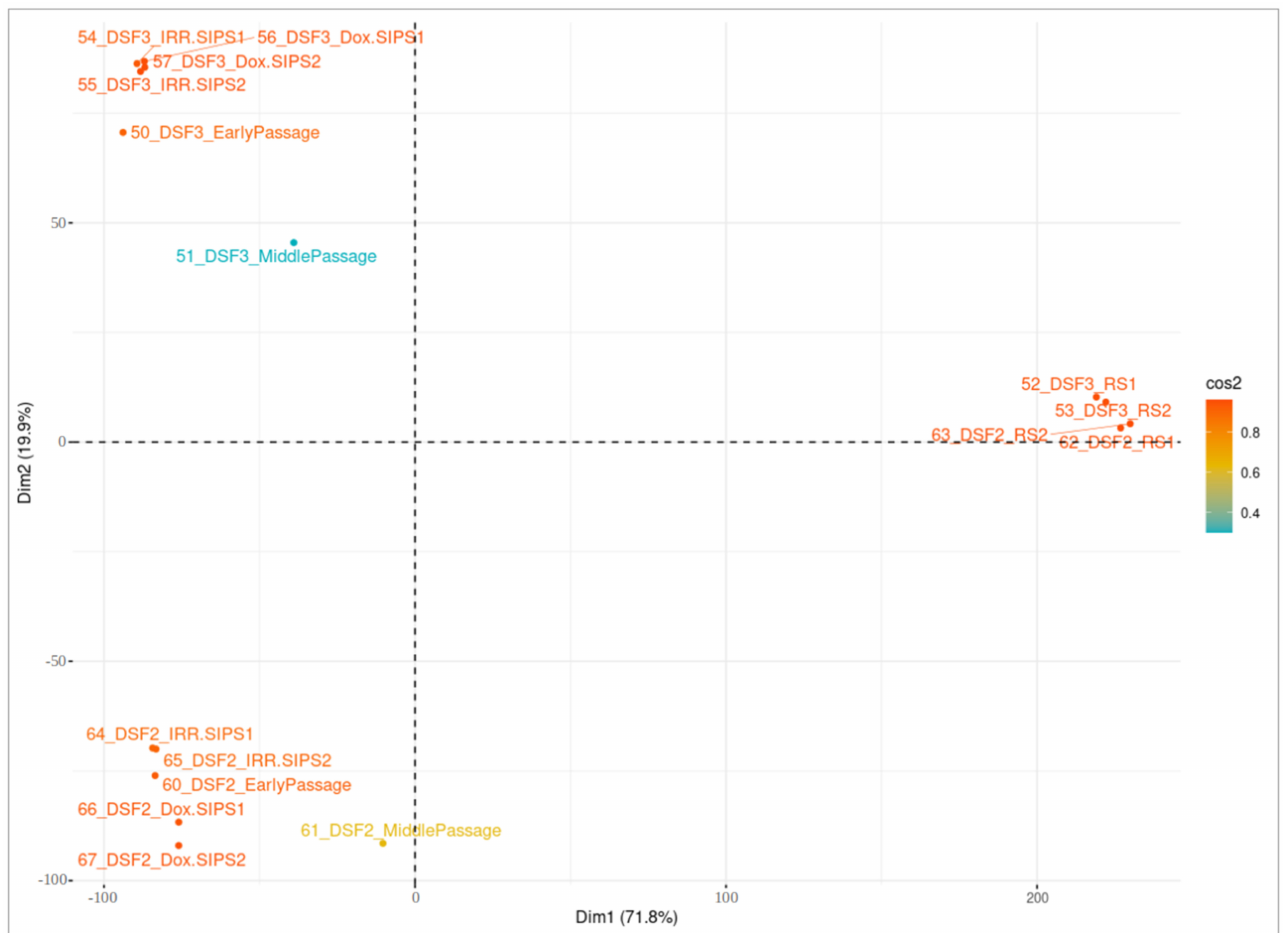
Figure 3. Visualization of cluster analysis in human DSF samples. Principal component analysis (PCA) was performed on normalized β -values of unique differentially methylated positions in cells after a middle number of passages (MidPass), in replicative senescence (RS), in stress-induced premature senescence after exposure to ionizing irradiation (IRR-SIPS) and doxorubicin (Dox-SIPS). X-axis “Dim1” corresponds to the first principal component of PCA, and Y-axis “Dim2” to the second principal component. The percentage of total variability explained by the component is indicated in brackets. Colors reflect the quality of representation on the cluster map (cos2). Labels correspond to samples (for detailed explanation of sample indicators, consult Figure